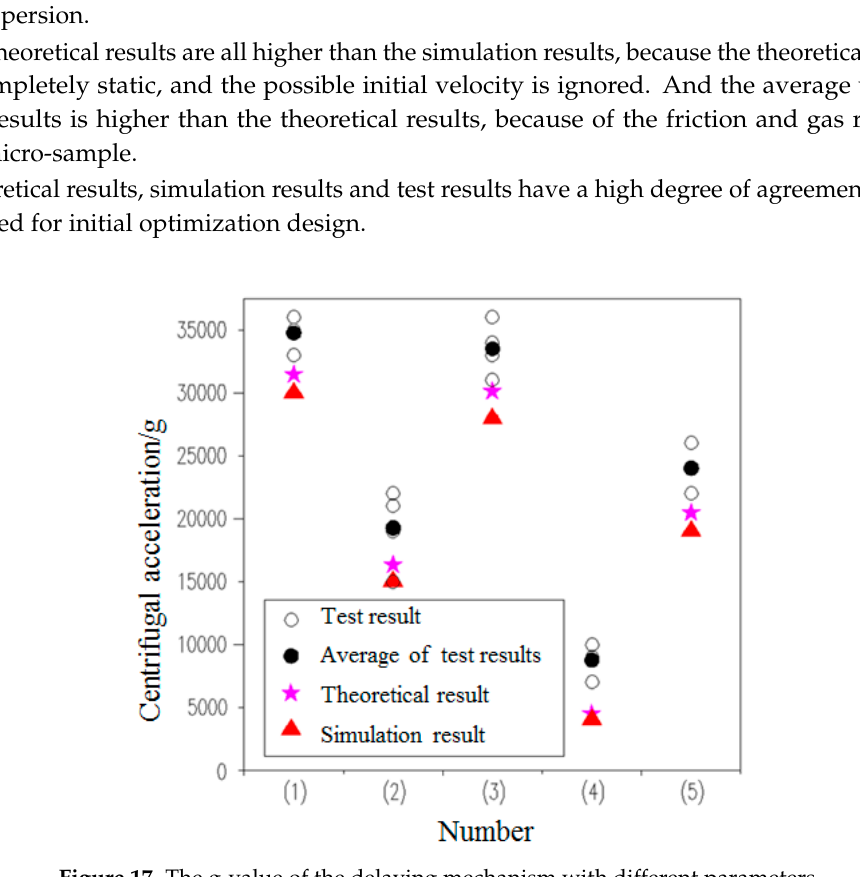
Figure 17. The g-value of the delaying mechanism with different parameters.